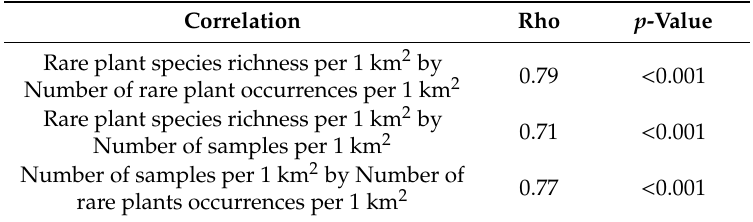
Table 1. Spearman rank correlation analysis of the rare plant species richness, number of rare plant occurrences, and number of samples all within 1 square kilometer across the Natural Communities Coalition (NCC) Reserve System. All variables were significantly positively correlated. This indicates that species richness increases with sampling e ff